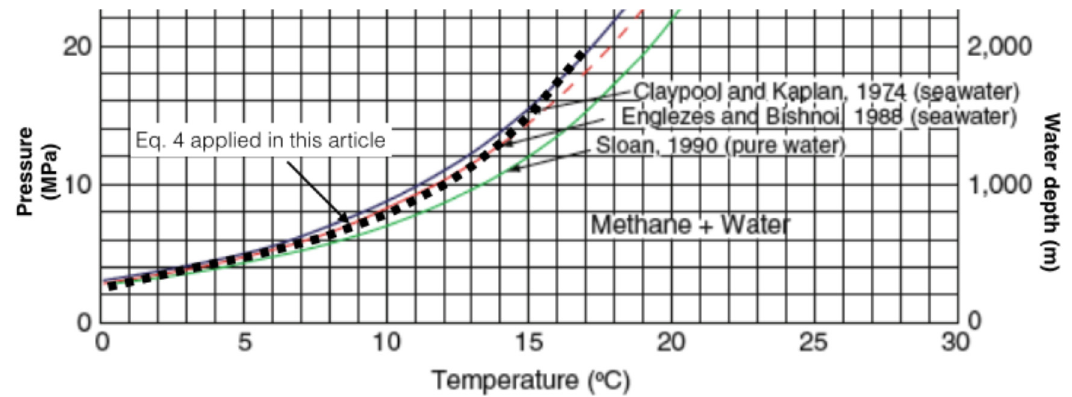
Figure 2. Gas hydrates phase boundary conditions, according to several authors (Adapted from Thakur [12]). Also depicted (dashed black line) the non-linear equation applied in this